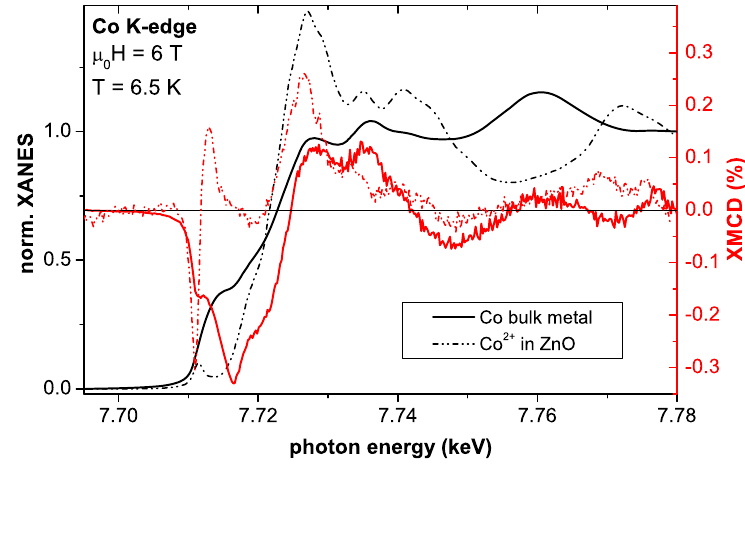
Figure 2. Experimental XANES (black) and corresponding XMCD (red) spectra recorded with left and right circular polarized light at the Co K -edge of bulk Co metal (full line) and c -oriented Co:ZnO (dash-dotted line) at 6.5 K and 6 T. The fine structure of the XANES and the XMCD is significantly different for the two Co